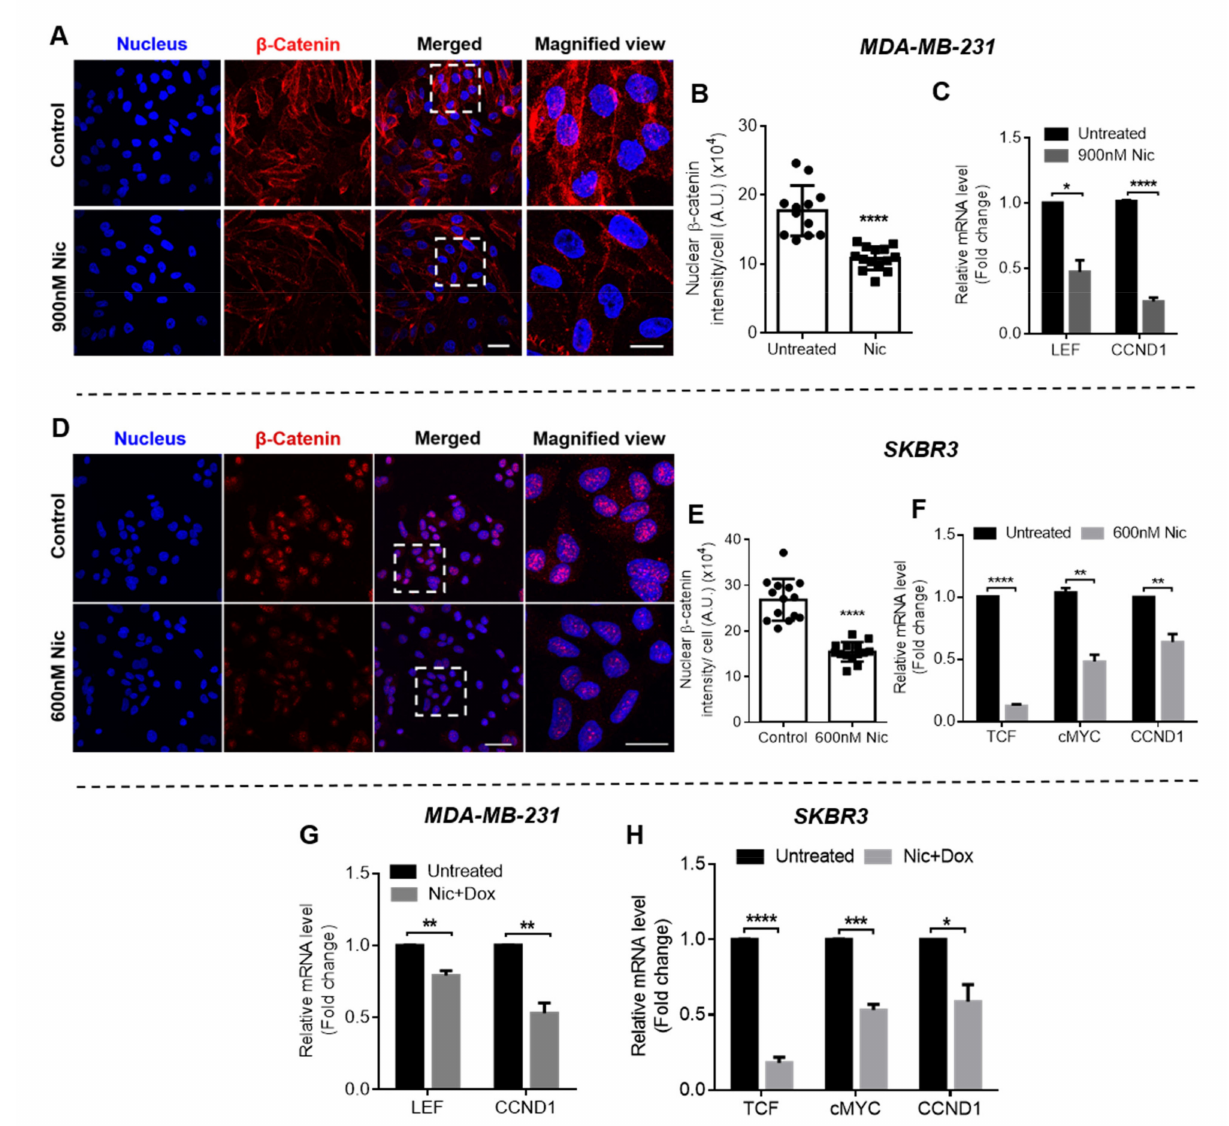
Figure 6. Wnt signaling analysis in breast cancer cells after individual and concurrent treatment of Nic and Dox. Repre- sentative images of β -catenin immunostaining of ( A ) MDA-MB-231 and ( D ) SKBR3 cells after 48 h treatment of Nic (scale bar- 40 µ m; magnified view- 20 µ m). Quantification of nuclear β -catenin from immunofluorescent images shown in ( A , D ) using MATLAB software in ( B ) MDA-MB-231 and ( E ) SKBR3 cells. Data represents mean values ± SD ( n = 12–14 images). Gene expression analysis of Wnt/ β -catenin signaling markers LEF, TCF, cMYC, and CCND1 after 48 h treatment with ( C , F ) Nic; and ( G , H ) combination of Nic and Dox, in MDA-MB-231 and SKBR3 cells. Normalization performed with GAPDH expression. * ( p < 0.05); ** ( p < 0.01), *** ( p < 0.001), and **** ( p < 0.0001) indicate statistically significant difference with respect to the untreated group ( n =